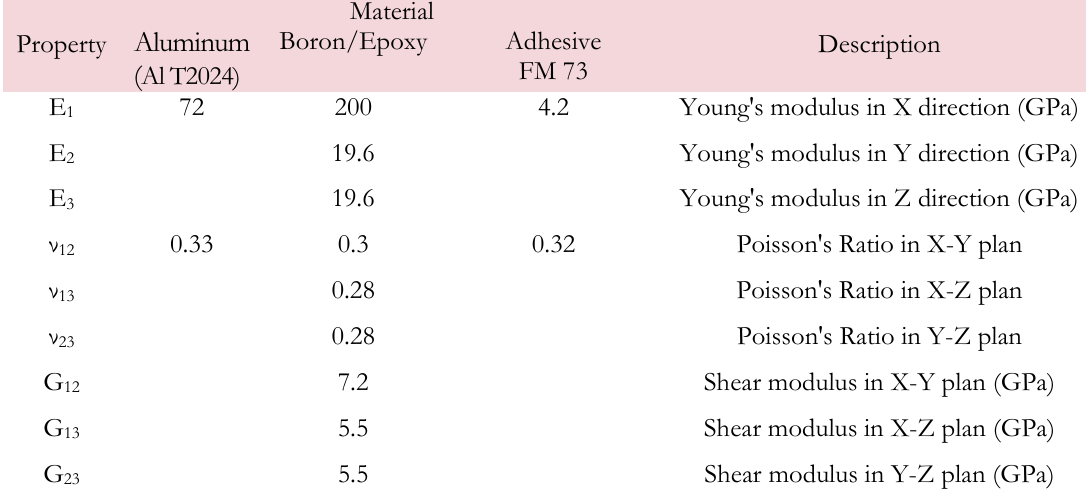
Table 1: Mechanical proprieties of